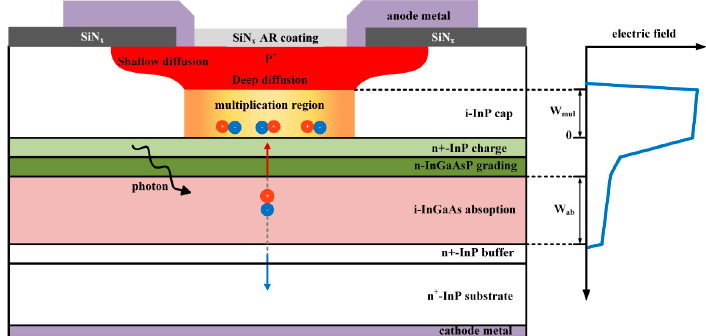
Figure 1. Two-dimensional (2D) schematic of the InP / InGaAs single-photon avalanche diode (SPAD). The electric field profile is shown on the right.